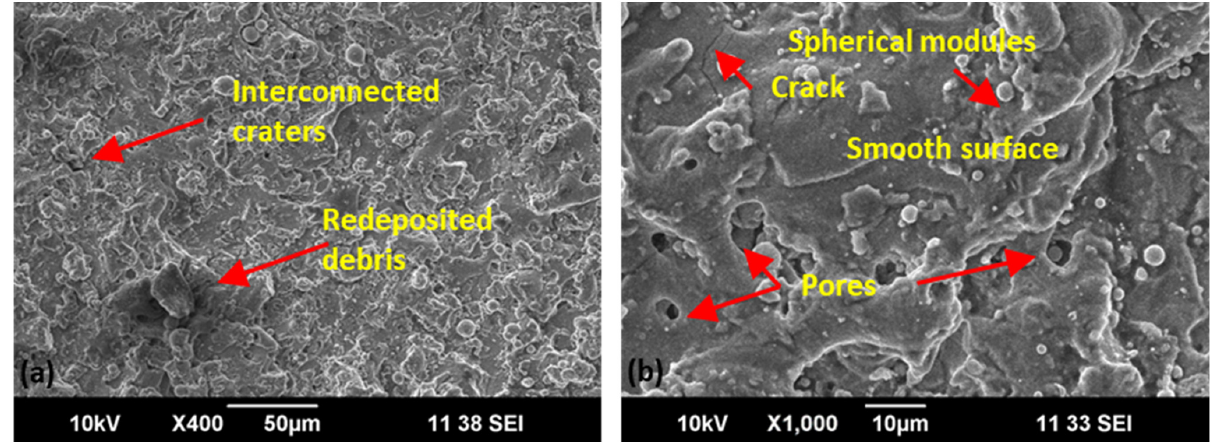
Figure 15. Scanning electron microscopic analysis of straight geometry for optimal parametric setting (V S 50 V, F P 4 kg/cm 2 , Ø N 8 mm, and W D 10 mm) at × 400 ( a ) and × 1000 ( b ).